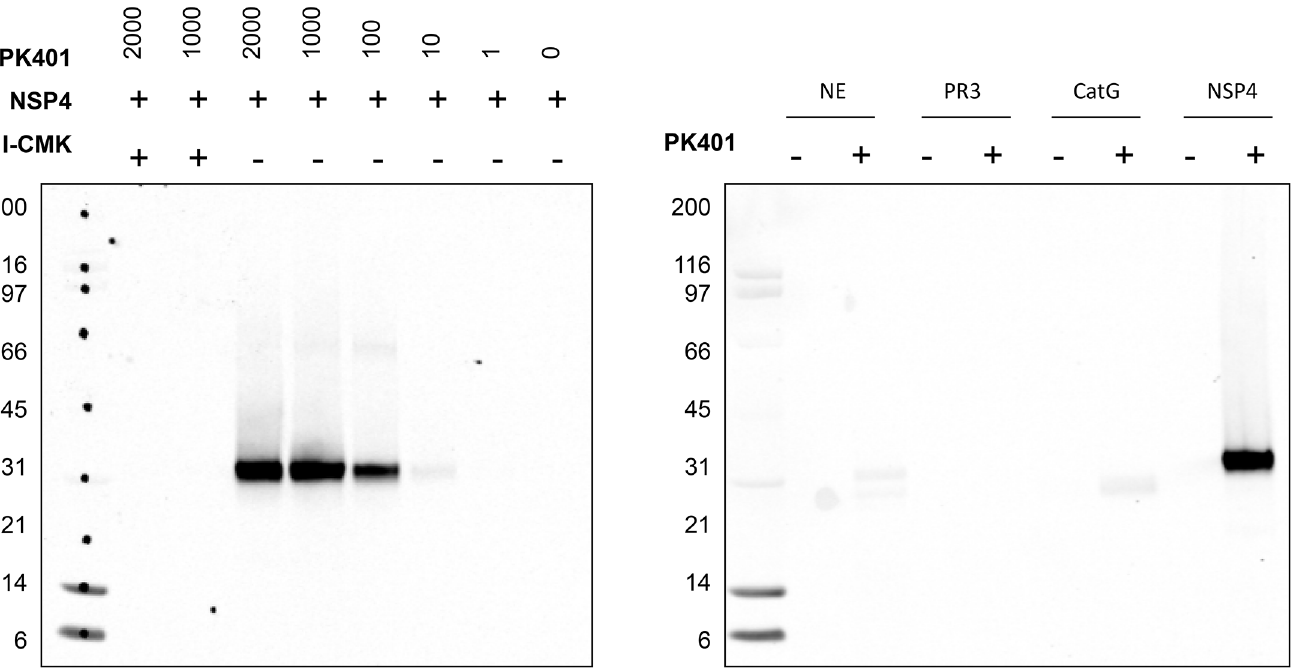
Fig 4. Visualization of PK401 with purified NSP4 and all NSP ’ s. (A) NSP4 was treated with PK401 in a range from 1 to 2000nM. (B) 100nM of NE, PR3, CatG and NSP4 with or without 100nM of PK401. (A, B) Samples were denatured in SDS sample buffer, run in SDS/PAGE followed by membrane transfer. The blot was developed with fluorescently-tagged streptavidin and imaged by fluorescence scanning (See S1 Text).